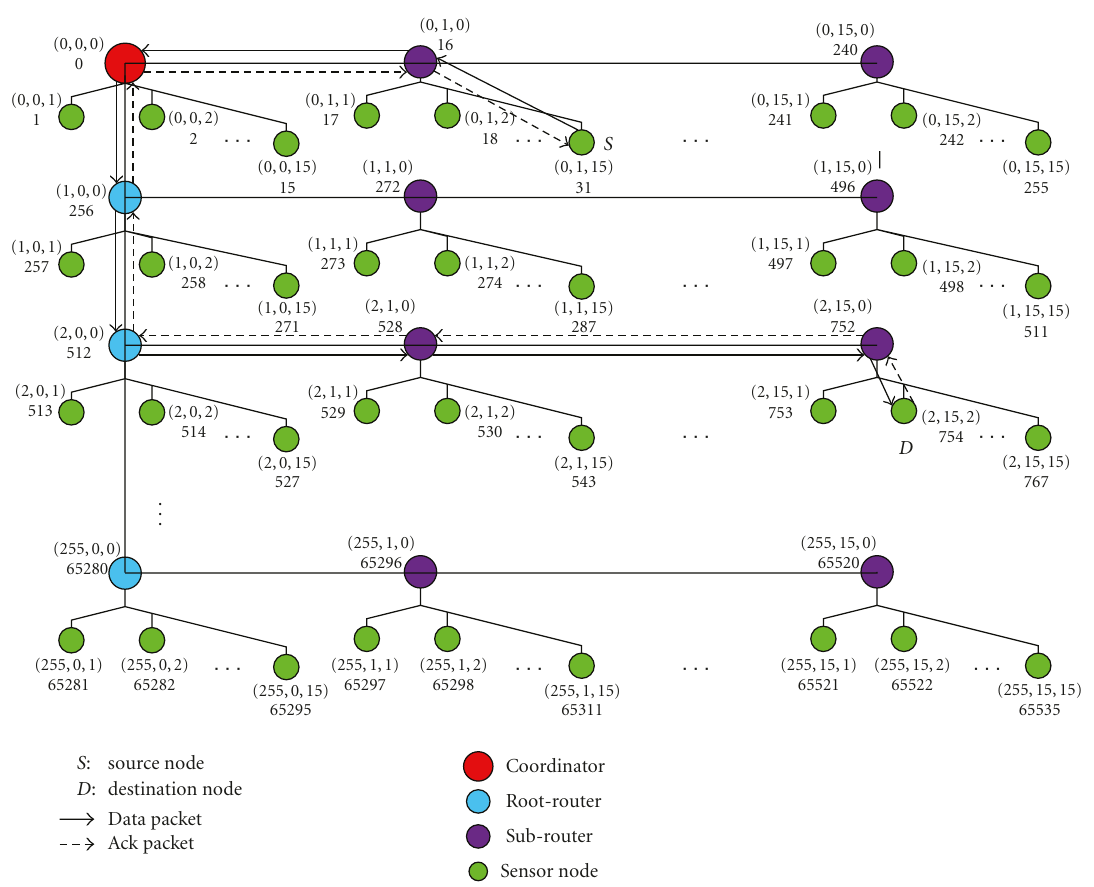
Figure 9: The expected routing path of a message from a source node (0,1,15) to a destination node (2,15,2) under 3D AACS